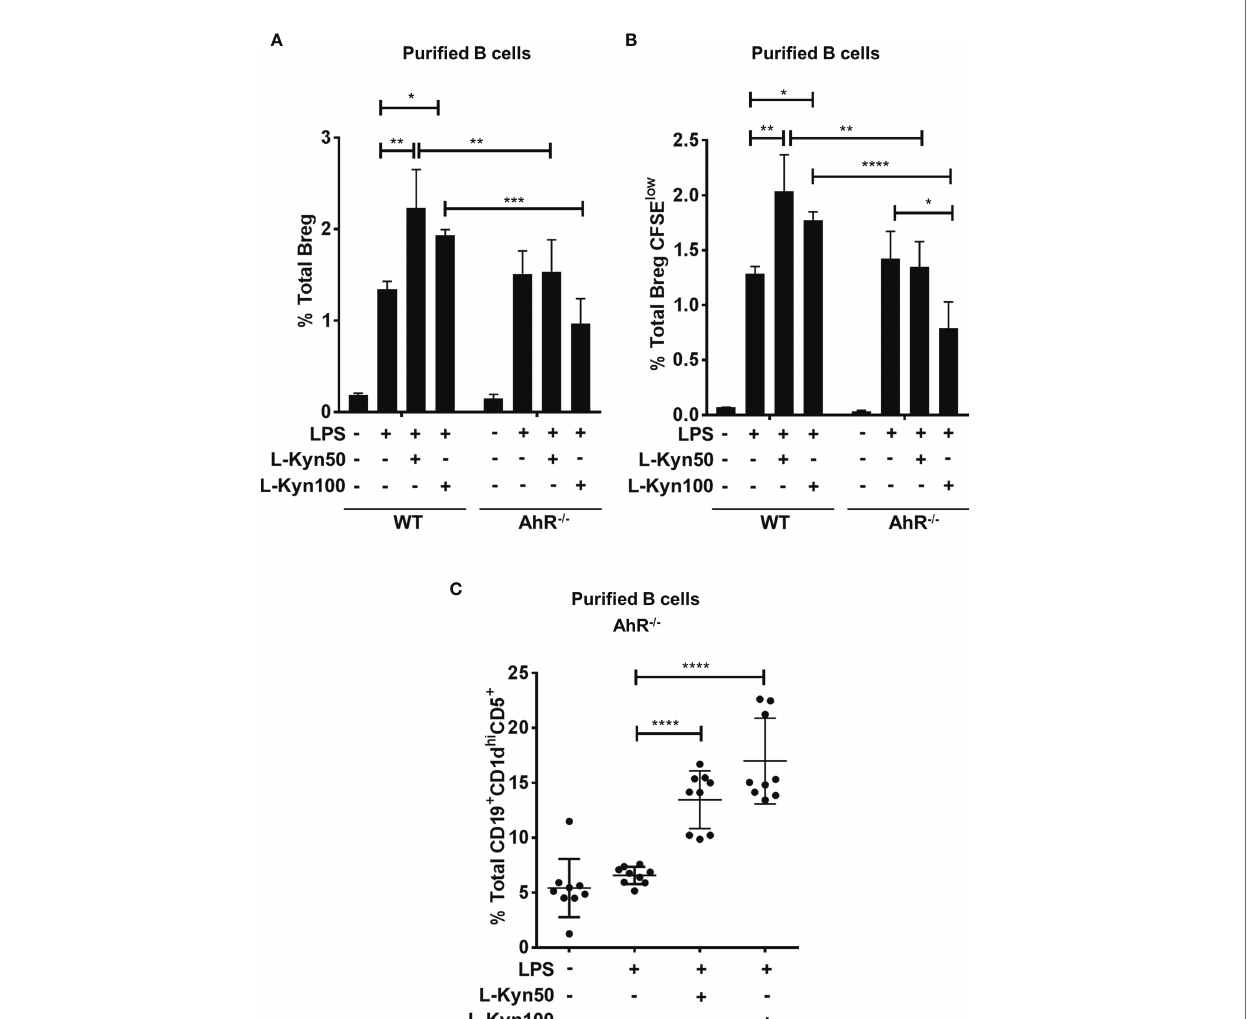
FIGURE 5 | AhR de fi ciency in B cells impaired Breg differentiation ex-vivo . CD19 + B cells were negatively selected from whole splenocytes of wild-type (WT), and AhR -/- , mice were disaggregated and seeded with LPS (10 m g/ml), and increasing concentrations of L-Kyn (50µM and 100 m M) for 72 hrs. Bregs were identi fi ed as CD19 + CD5 + CD1d hi IL-10 + by fl ow cytometry. (A) AhR de fi ciency inhibited L-Kyn induced Breg differentiation following stimulation of B cells with LPS+L-Kyn. Data shown here are representative of three independent experiments with three replicates for each group and represent the mean ± STDEV values. (B) AhR de fi ciency altered the proliferation of Breg. CD19 + cells were negatively selected from whole splenocytes of WT, and AhR -/- mice and labeled with CFSE and then stimulated with LPS and increasing concentrations of L-Kyn for 72 hrs. Total percentages of Breg + CFSE low (CD19 + CD5 + CD1d hi IL-10 + CFSE low ) cells were determined by fl ow cytometry analysis. Data shown here are representative of two independent experiments with 3 technical replicates in each condition. (C) Breg precursors (CD19 + CD1d hi CD5 + ) induced by LPS+L-Kyn were not impaired in AhR -/- . Total percentages of CD19 + CD1d high CD5 in AhR -/- were determined by fl ow cytometry analysis. Data shown here are pooled of three independent experiments with 3 technical replicates in each condition. *p < 0.05, **p < 0.001, ***p < 0.0001, ****p <